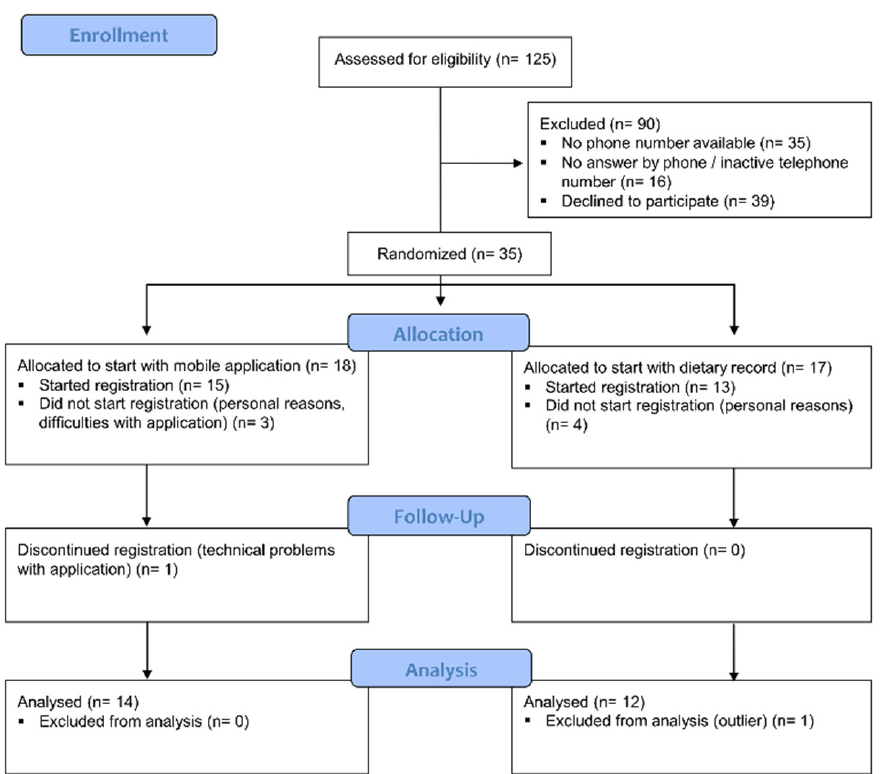
Figure 1. Flowchart of the study selection procedure.